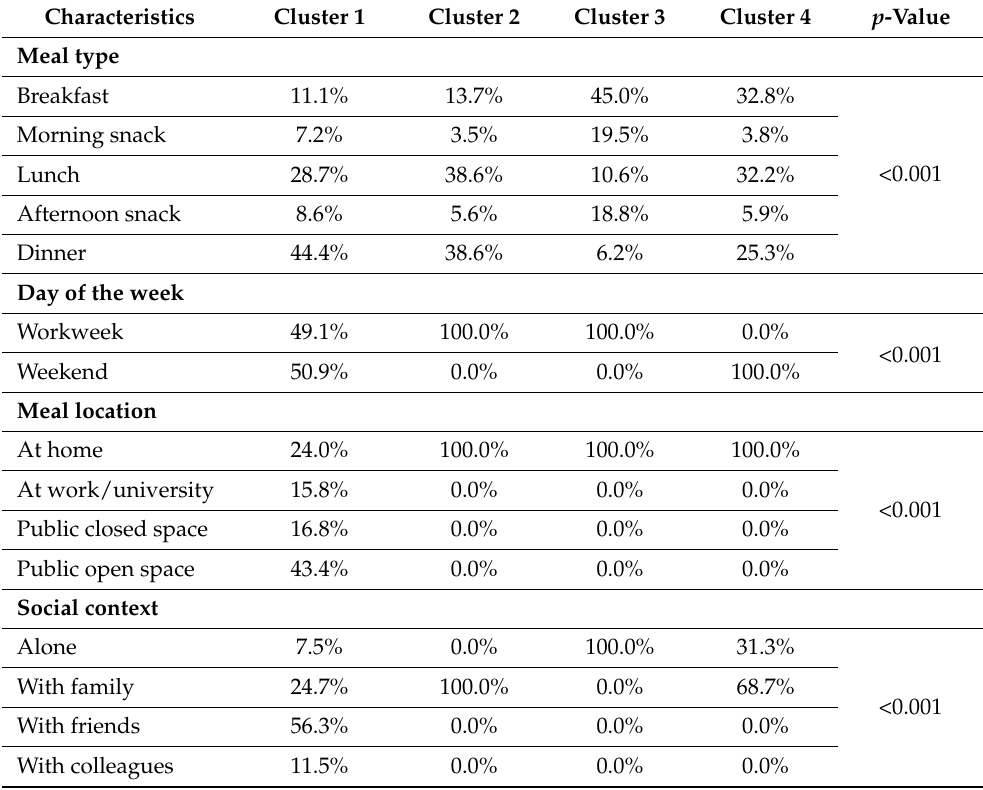
Figure 4. Sunburst chart of characteristics of eating episodes. This multilevel chart summarizes the distribution of eating episodes according to meal type, meal location, and social context. The size of each segment is proportional to the corresponding values. The inner ring refers to the meal type (breakfast, morning snack, lunch, afternoon snack, dinner); the medium ring refers to the meal location (at home versus other places); the outer ring refers to the social context (alone versus in company). Table 2. Characteristics of clusters of eating episodes. This table shows the distribution of characteris- tics of eating episodes according to the cluster solution